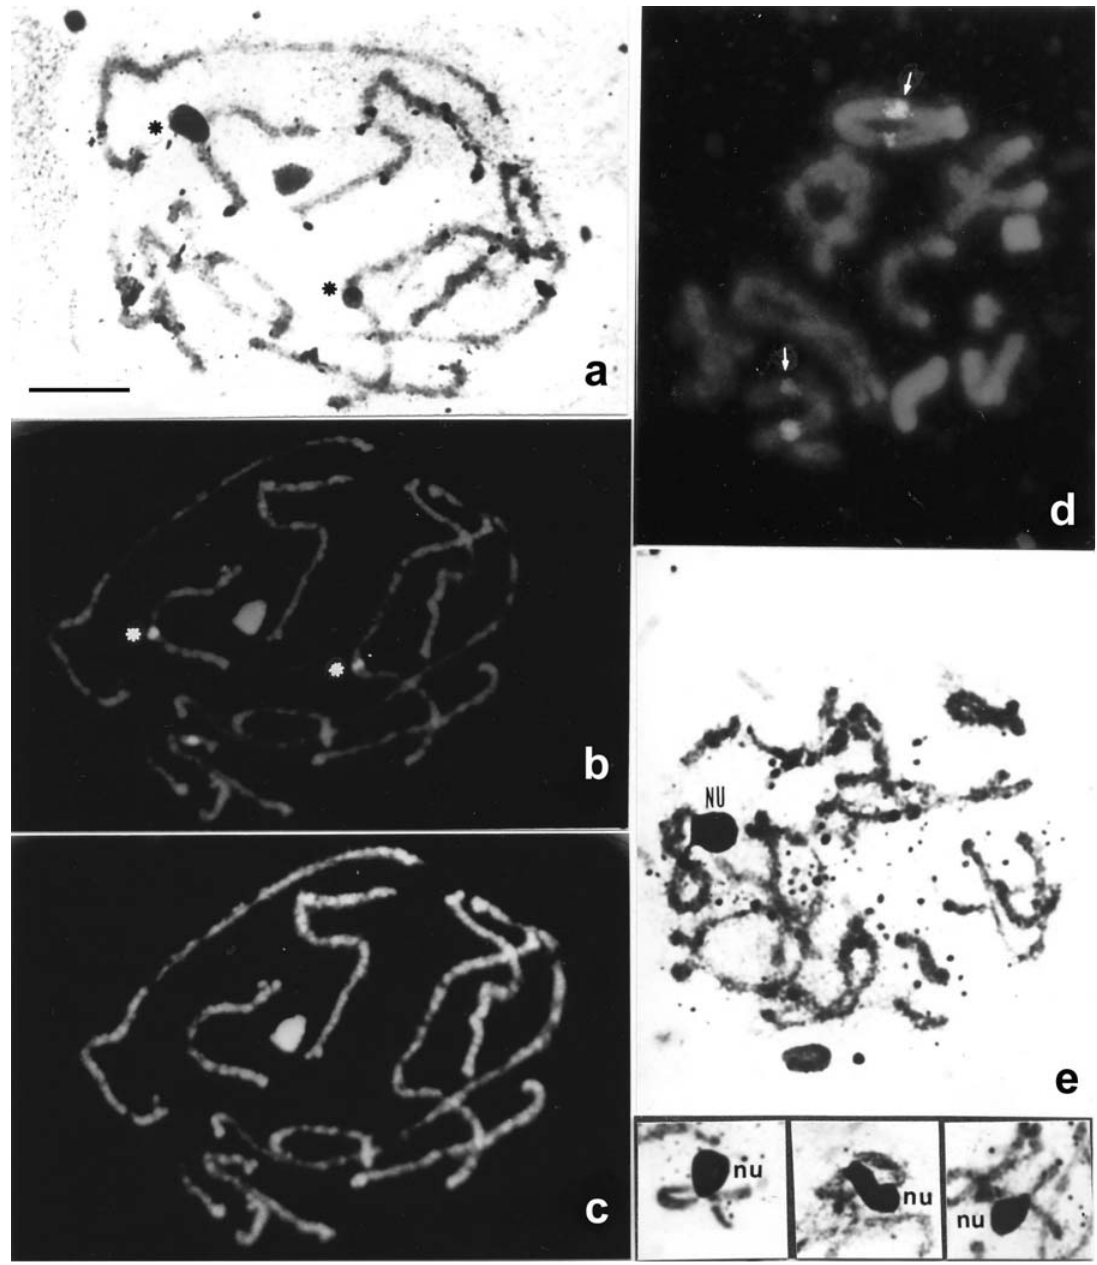
Figure 3 - (a-c) AgNO 3 /CMA 3 /DA/DAPI sequential staining and (d) FISH with a 45S rDNA probe in S. pallens . Asterisks indicate Ag-NORs in (a), and the CMA 3 -positive block in (b); arrows point to the interstitial rDNA FISH signals on M5 and M6 in (d). (e) Ag-NORs (NU) on M5 of S. flavofasciata . In the inset, the Ag-NOR-bearing M5 in different cells. (a, b, c, e) pachytene; (d) diplotene. Bar = 10 μ